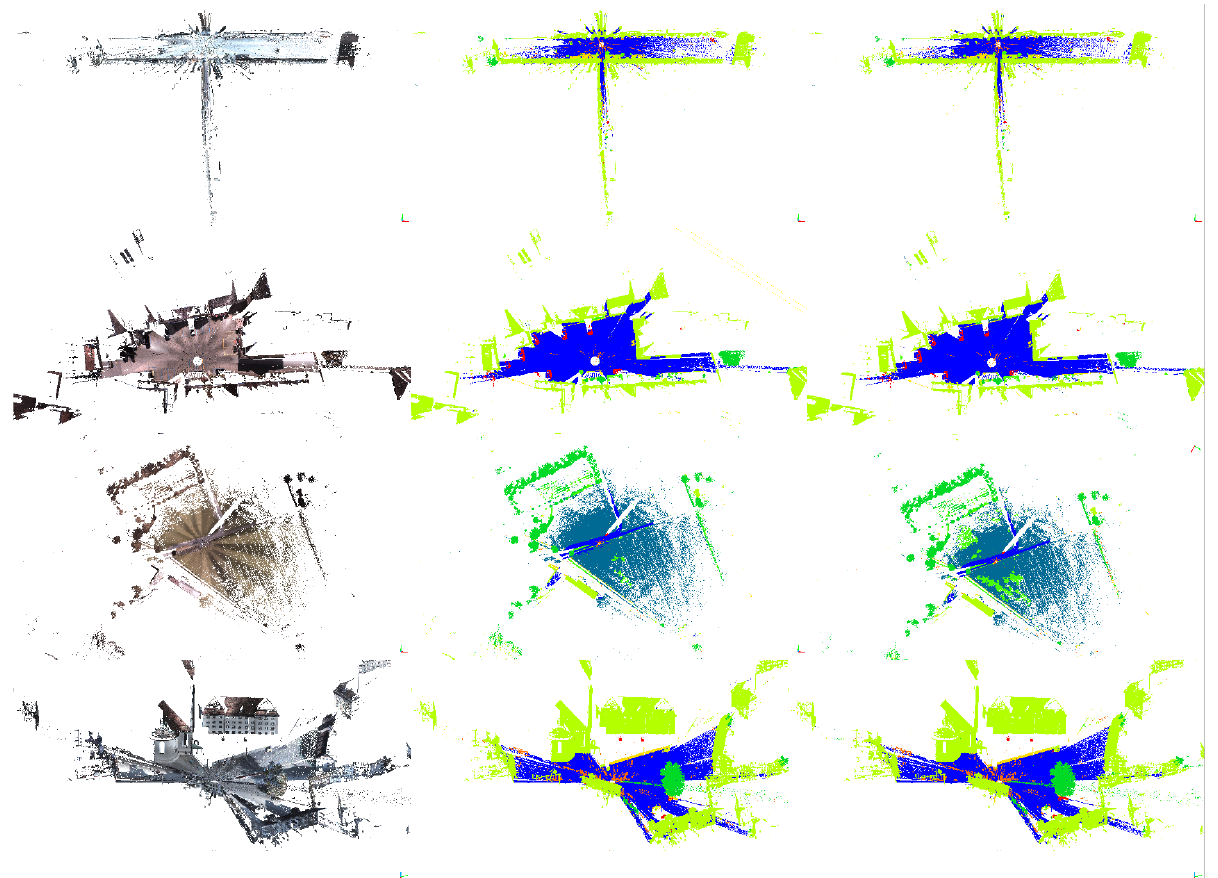
Figure 11. The semantic segmentation results for the reduced-8 data: The left column shows the original data. The middle column shows the predicted results with color. The right column shows the predicted results without color.